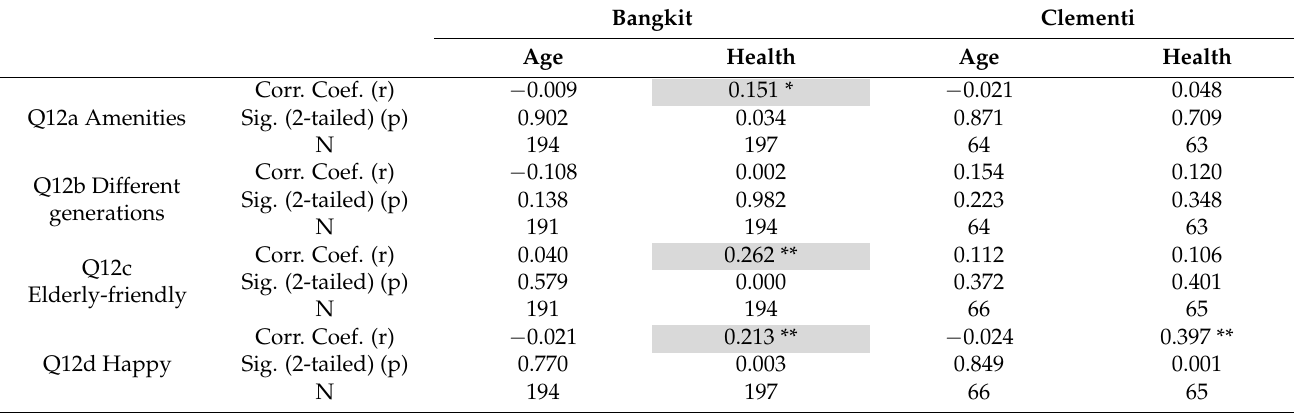
Table 14. Spearman correlation test: correlation between overall satisfaction with the neighbourhood (Question 12 of Socio-sensory Survey, Appendix A), age and health